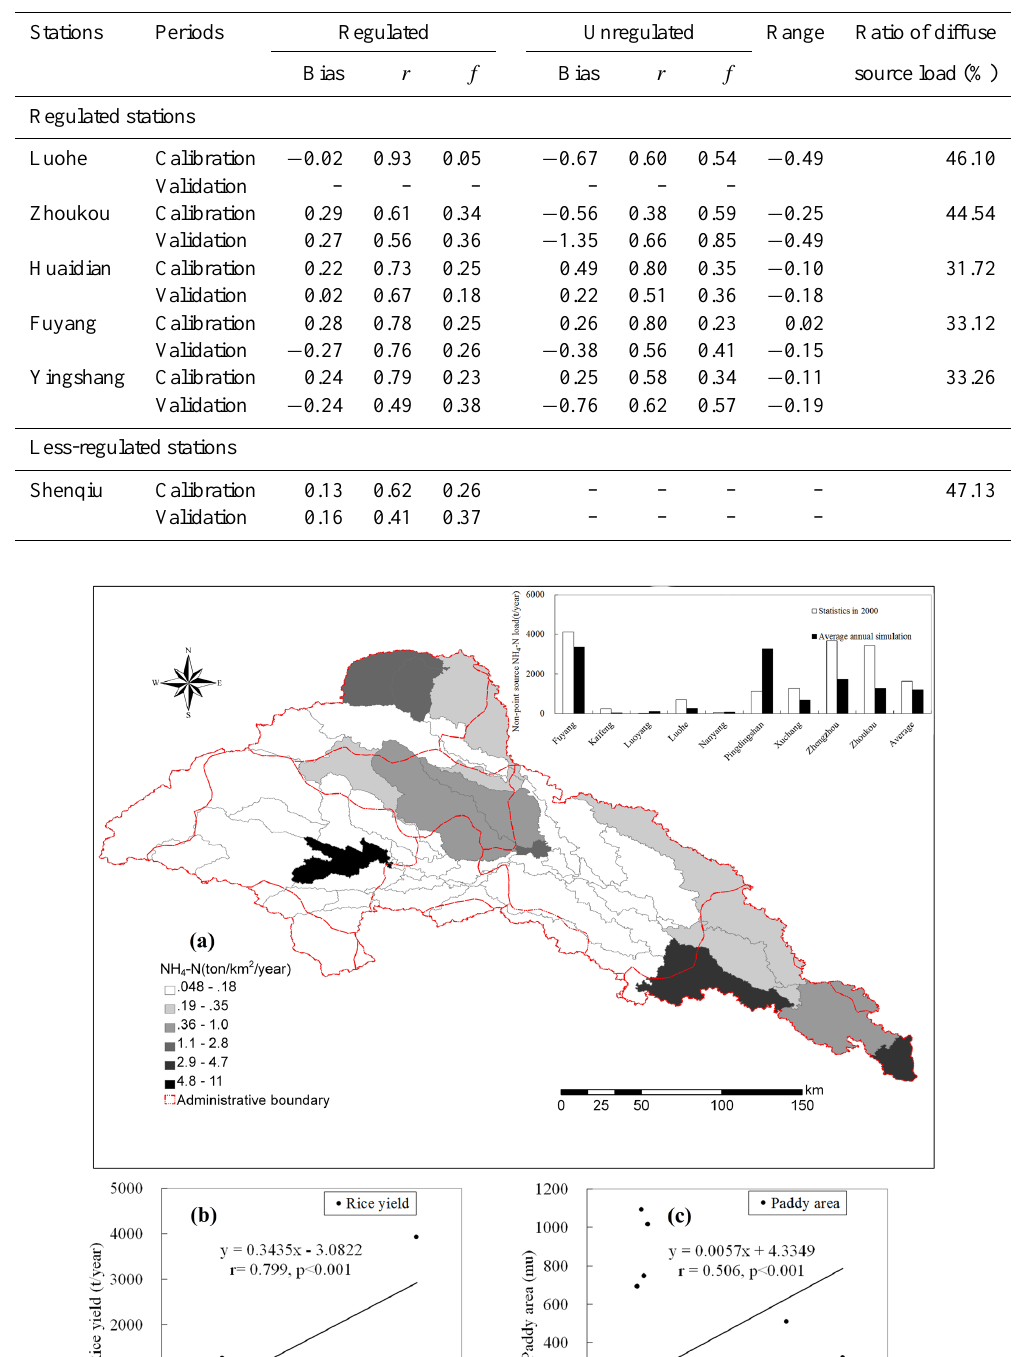
Table 5. The comparison of NH 4 –N simulation results with and without dam regulation considered.